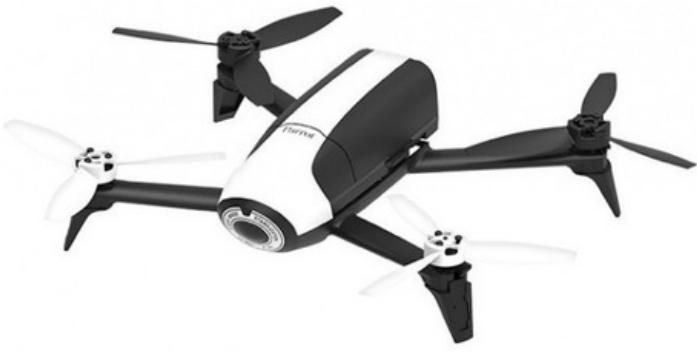
Figure 16. The Parrot Bebop 2.